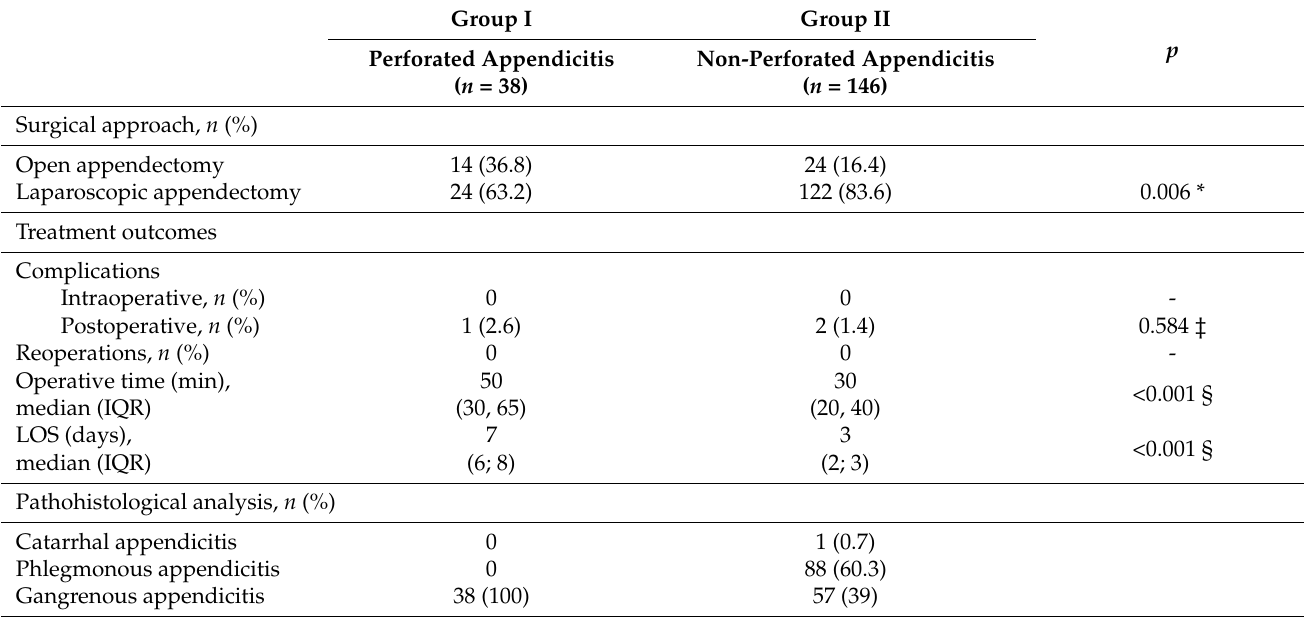
Table 3. Surgical approach, treatment outcomes, and results of the pathohistological